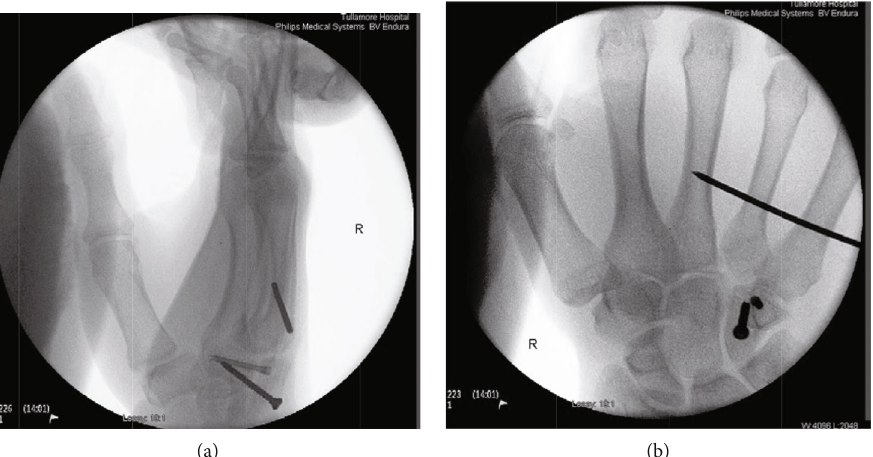
Figure 3: (a, b) Intraoperative screening showing satisfactory reduction and alignment of right dual hamate fracture using screw fi xation and K-wire stabilisation to the 3 rd -5 th